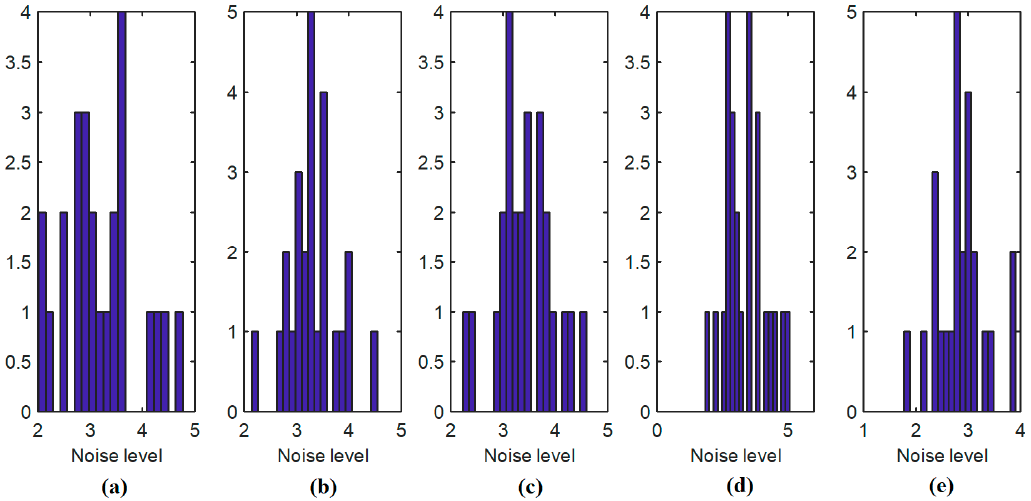
Figure 7. The distribution of noise level estimates corresponding to different image patches. All in a fully tessellated image are considered. The images: ( a ) Lena, ( b ) Town, ( c ) Couple, ( d ) Einstein, patches in a fully tessellated image are considered. The images: (a) Lena, (b) Town, (c) Couple, (d) and ( e ) Einstein, and (e) Girlface.